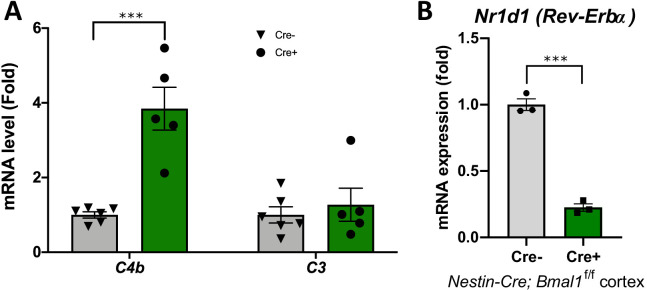
Brain-specific or post-natal Bmal1 deletion cause early induction of C4b.(A) qPCR analysis for complement genes in hippocampal tissue from global inducible Bmal1 KO mice (CAG-CreERT2;Bmal1f/f) and Cre- littermate controls. N = 5–6/group. Mice were all treated with tamoxifen at 2mo and harvested at 4mo. (B) Nr1d1 transcript levels in 12mo Cre- and Nestin-Cre+;Bmal1f/f mouse cortex, taken from microarray dataset (ArrayExpress E-MTAB-7151) presented in Figure 1A. N = 3 mice/genotype. ***p<0.0001 by two-tailed T-test with Welch’s correction.